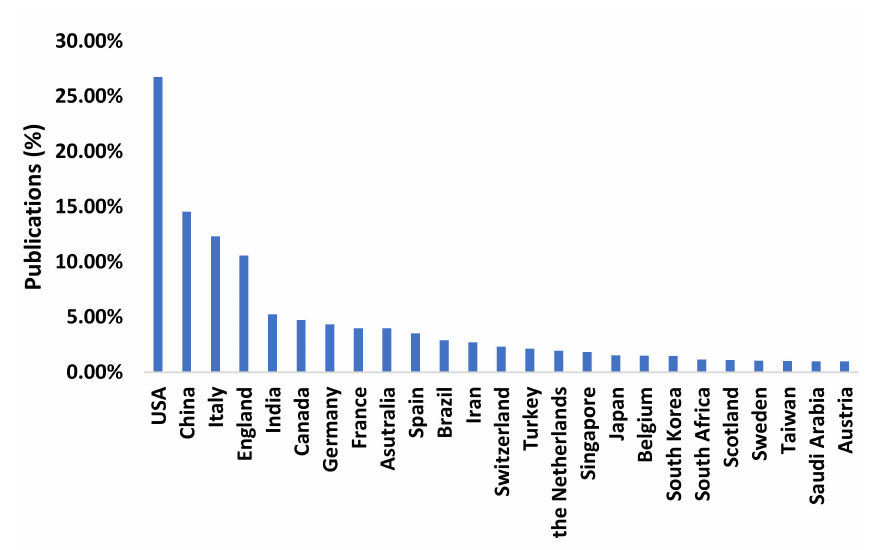
Figure 4. Publication rate by